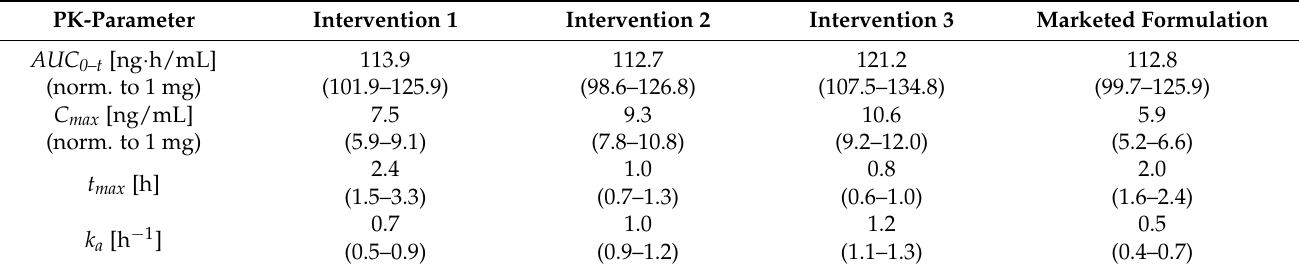
Table 2. Normalized Pharmacokinetic parameters mean (95%—CI) for intervention 1 (ASD of efavirenz 50 mg), intervention 2 (dissolved ASD of efavirenz 50 mg), intervention 3 (solution of efavirenz 3 mg), and the marketed formulation 50 mg [18]. This summary is provided under CONSORT guidelines [20].